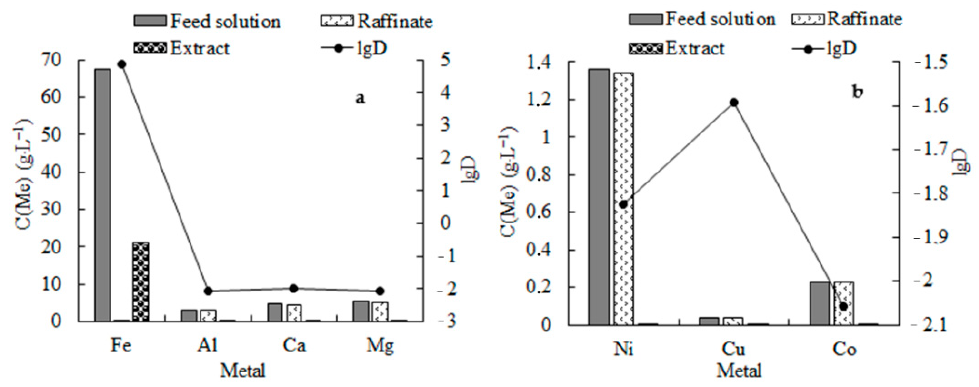
Figure 10. The results of solvent extraction of iron(III) from slag leaching solution. ( a )—Fe, Al, Ca,